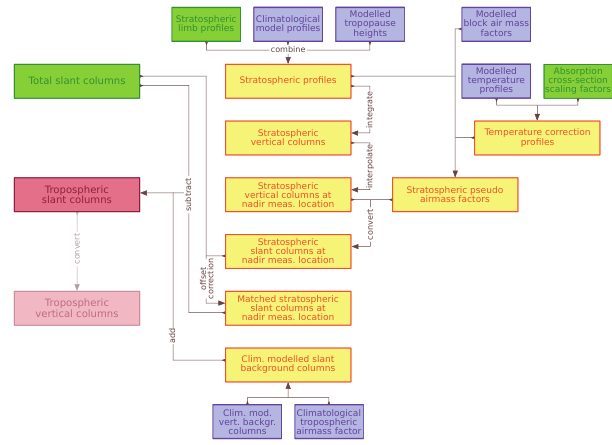
Fig. 1. Data flow of calculating tropospheric NO 2 columns from SCIAMACHY measurements. Measured and modelled quantities are shown in green and purple, respectively, while intermediate results are marked in yellow. Conversion of SCD trop to VCD trop involves calculation of tropospheric air mass factors, the discussion of which is beyond the scope of this